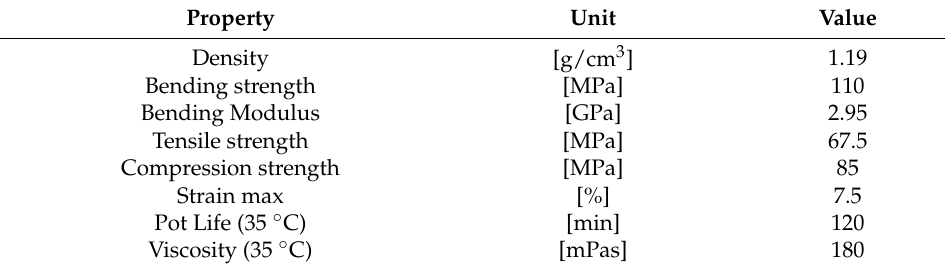
Table A2. Basic values of resin: Hexion